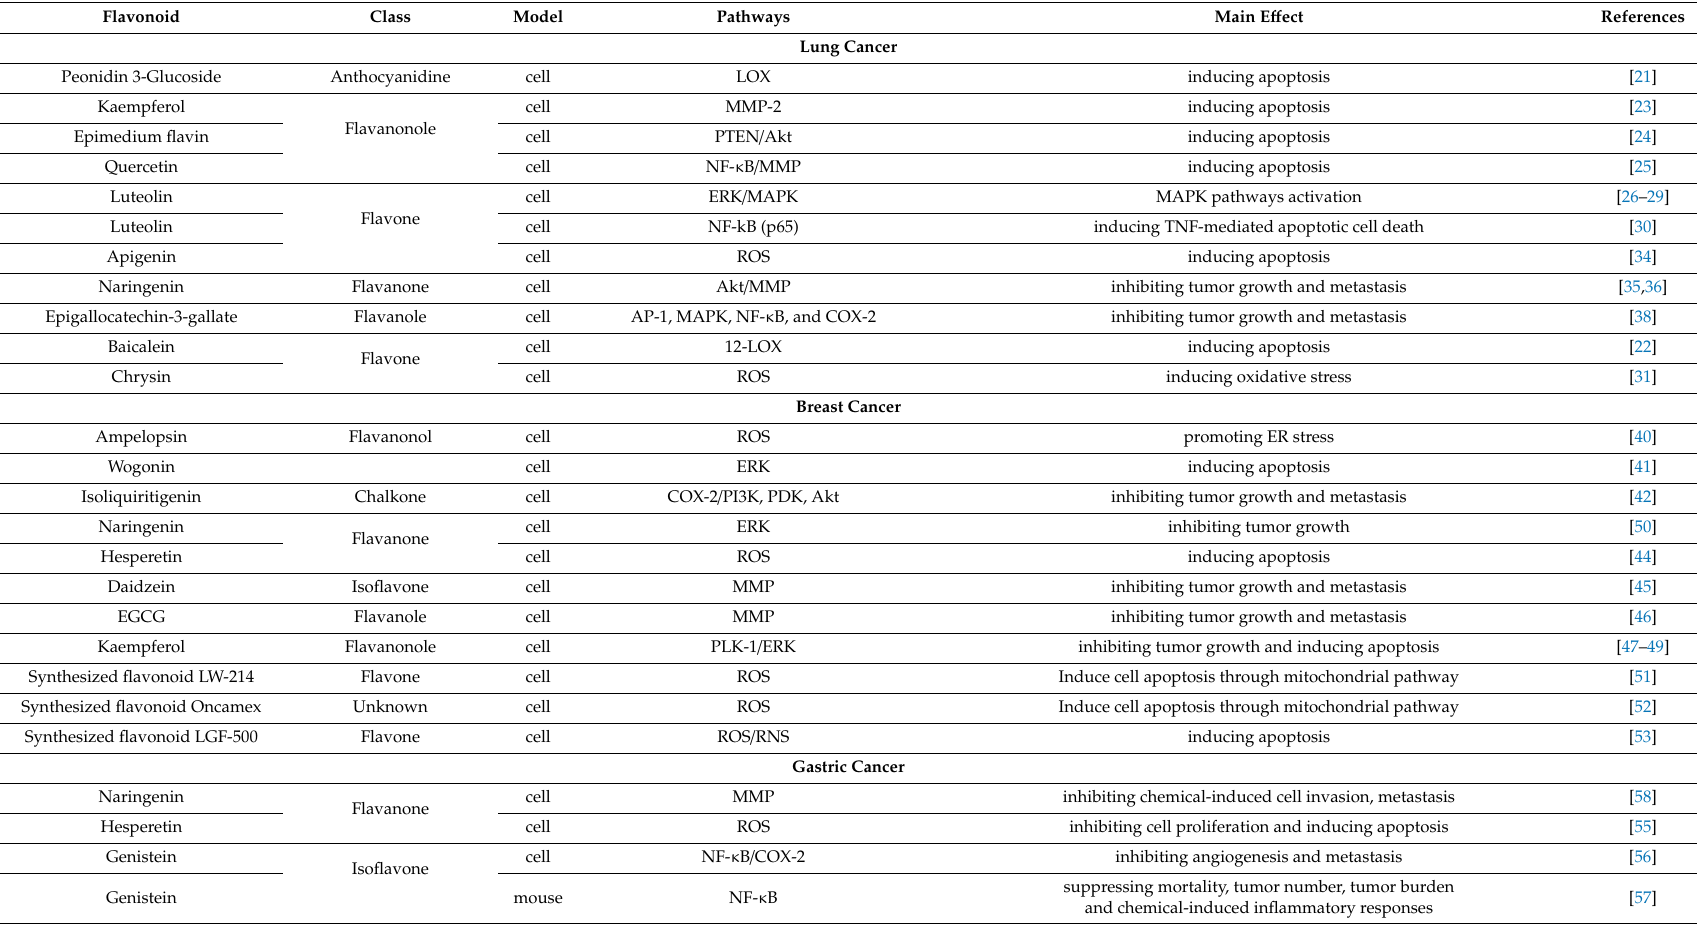
Table 1. The anti-cancer e ff ects of